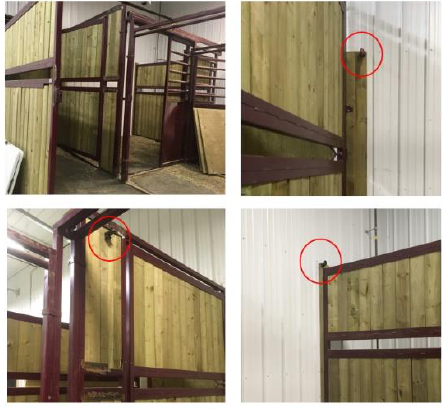
Figure 4. The pen and the camera mounts in red circles.